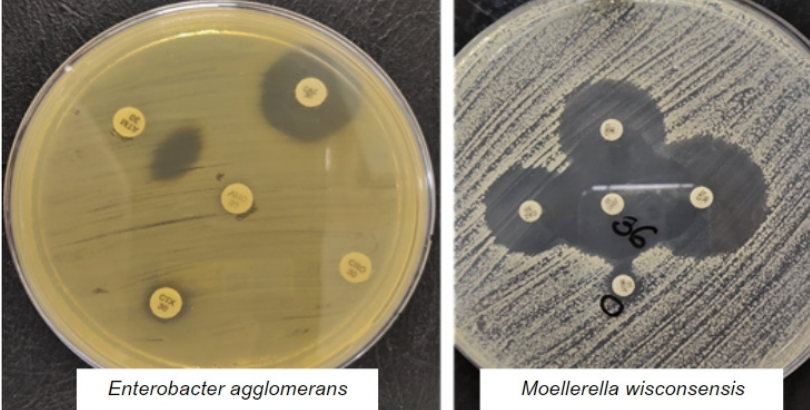
Figure 1. Phenotypic test for the detection of positive ESBL-producing strains, showing an increase or distortion in the zone of inhibition of one of the antibiotics (Cefotaxime, Ceftazidime, Ceftriaxone and Aztreonam) toward the amoxicillin + clavulanate disc of an isolate of Enterobacter agglomerans and one of Moellerella wisconsensis isolated from the hand of a milker and an insufflator, respectively. In addition to the presence of phenotypically resistant isolates, the presence of the mec A gene was found in 11 of the Staphylococcus spp. isolates, 8 (72.72%) from milk, 2 (18.18%) from milking machine and 1 (9.1%) from the hand of a milker (Tables 5 and 6). Table 5. Resistance profile of Staphylococcus spp. mec A gene carriers, from the municipality of Boa